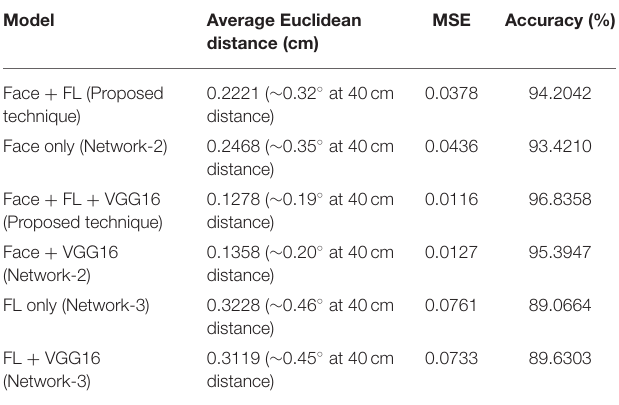
TABLE 3 | Results produced by the proposed technique for GazeCapture dataset.